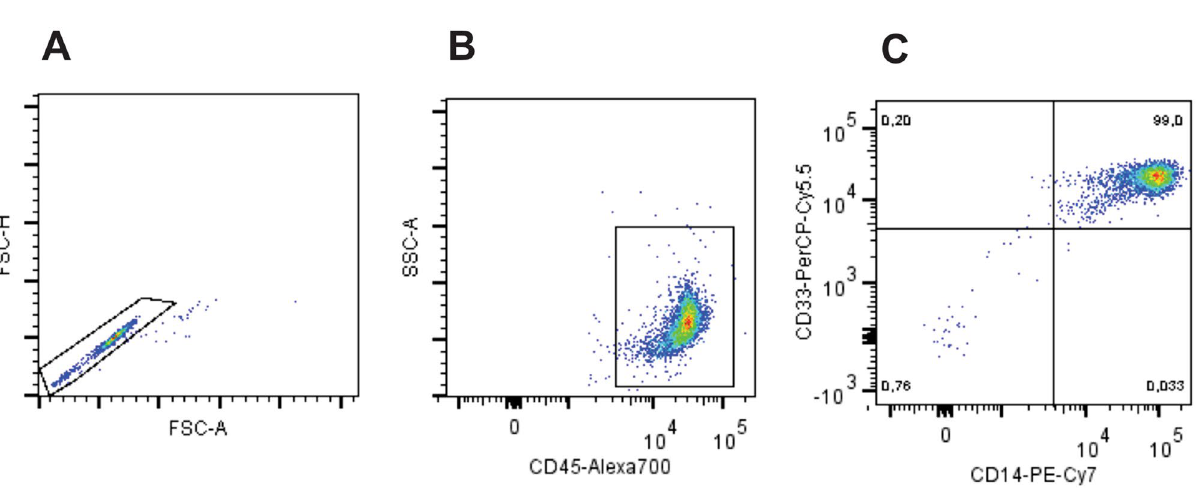
Figure 3. Flow cytometric analysis of CD14 selected monocytes used for dendritic cells differentiation. Flow cytometry dot plot analysis ( A ) Exclusion of doublets, gating on FSC-Area vs FSC-High; ( B ) sequential gate on cells expressing CD45; ( C ) and a final gate displaying 99% purity, almost all cells are identified as monocytes by the co-expression of CD14+ and